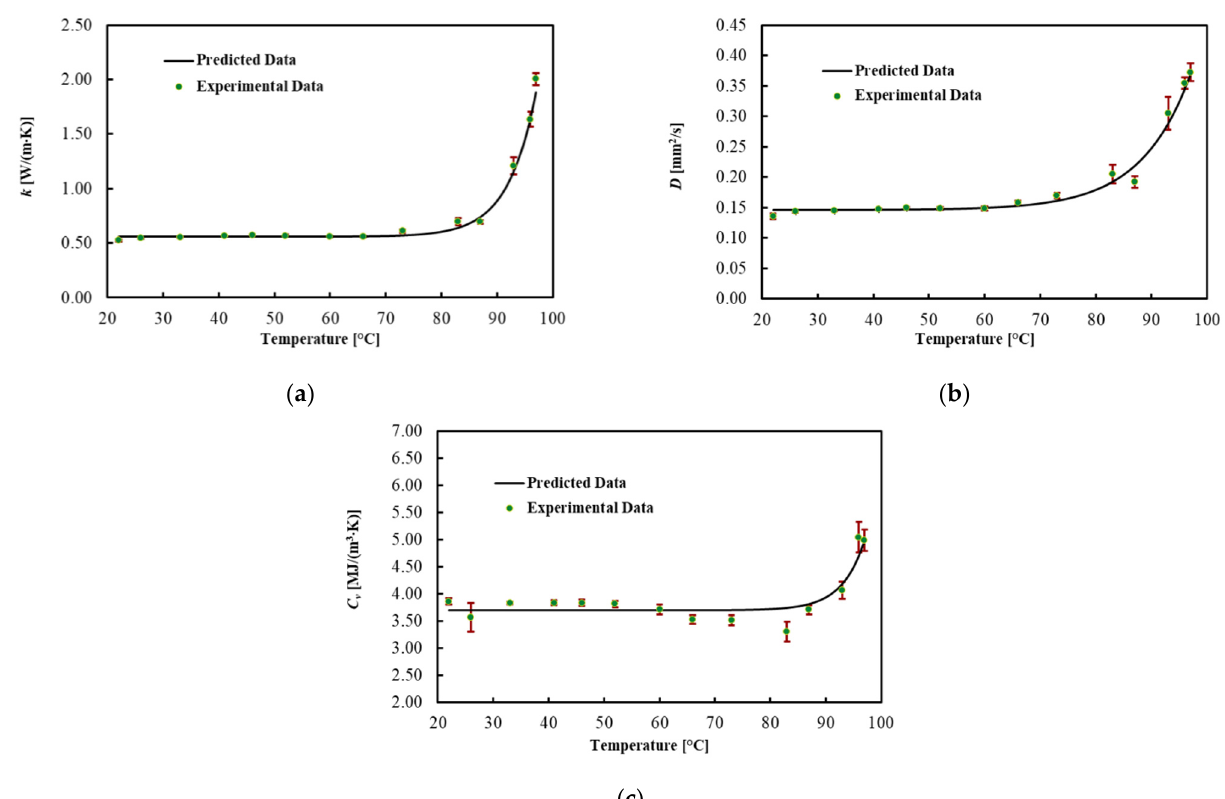
Figure 4. ( a ) Thermal conductivity, ( b ) thermal diffusivity and ( c ) volumetric heat capacity for ex vivo calf brains during heating. Table 3. Measured thermal properties for ex vivo calf brains at different temperatures and their associated measurement uncertainty with 95% confidence level.